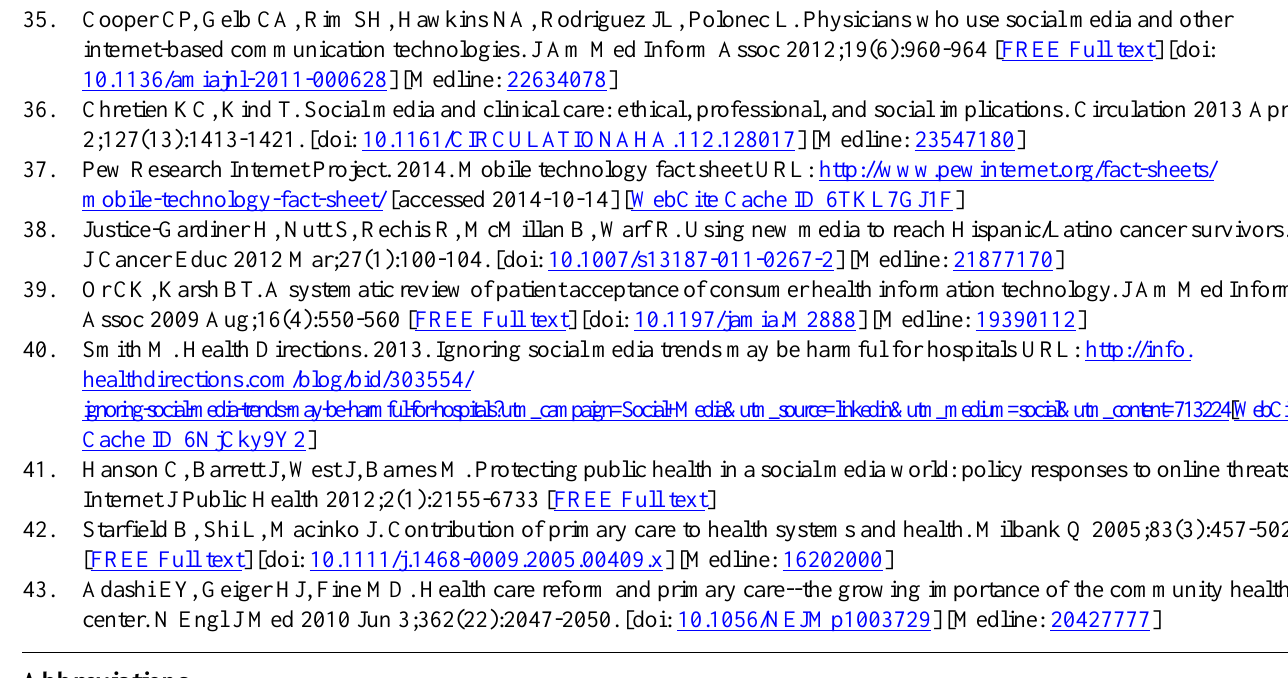
FQHC: Federally Qualified Health Centers PPACA: Patient Protection and Affordable Care Act TPB: theory of planned